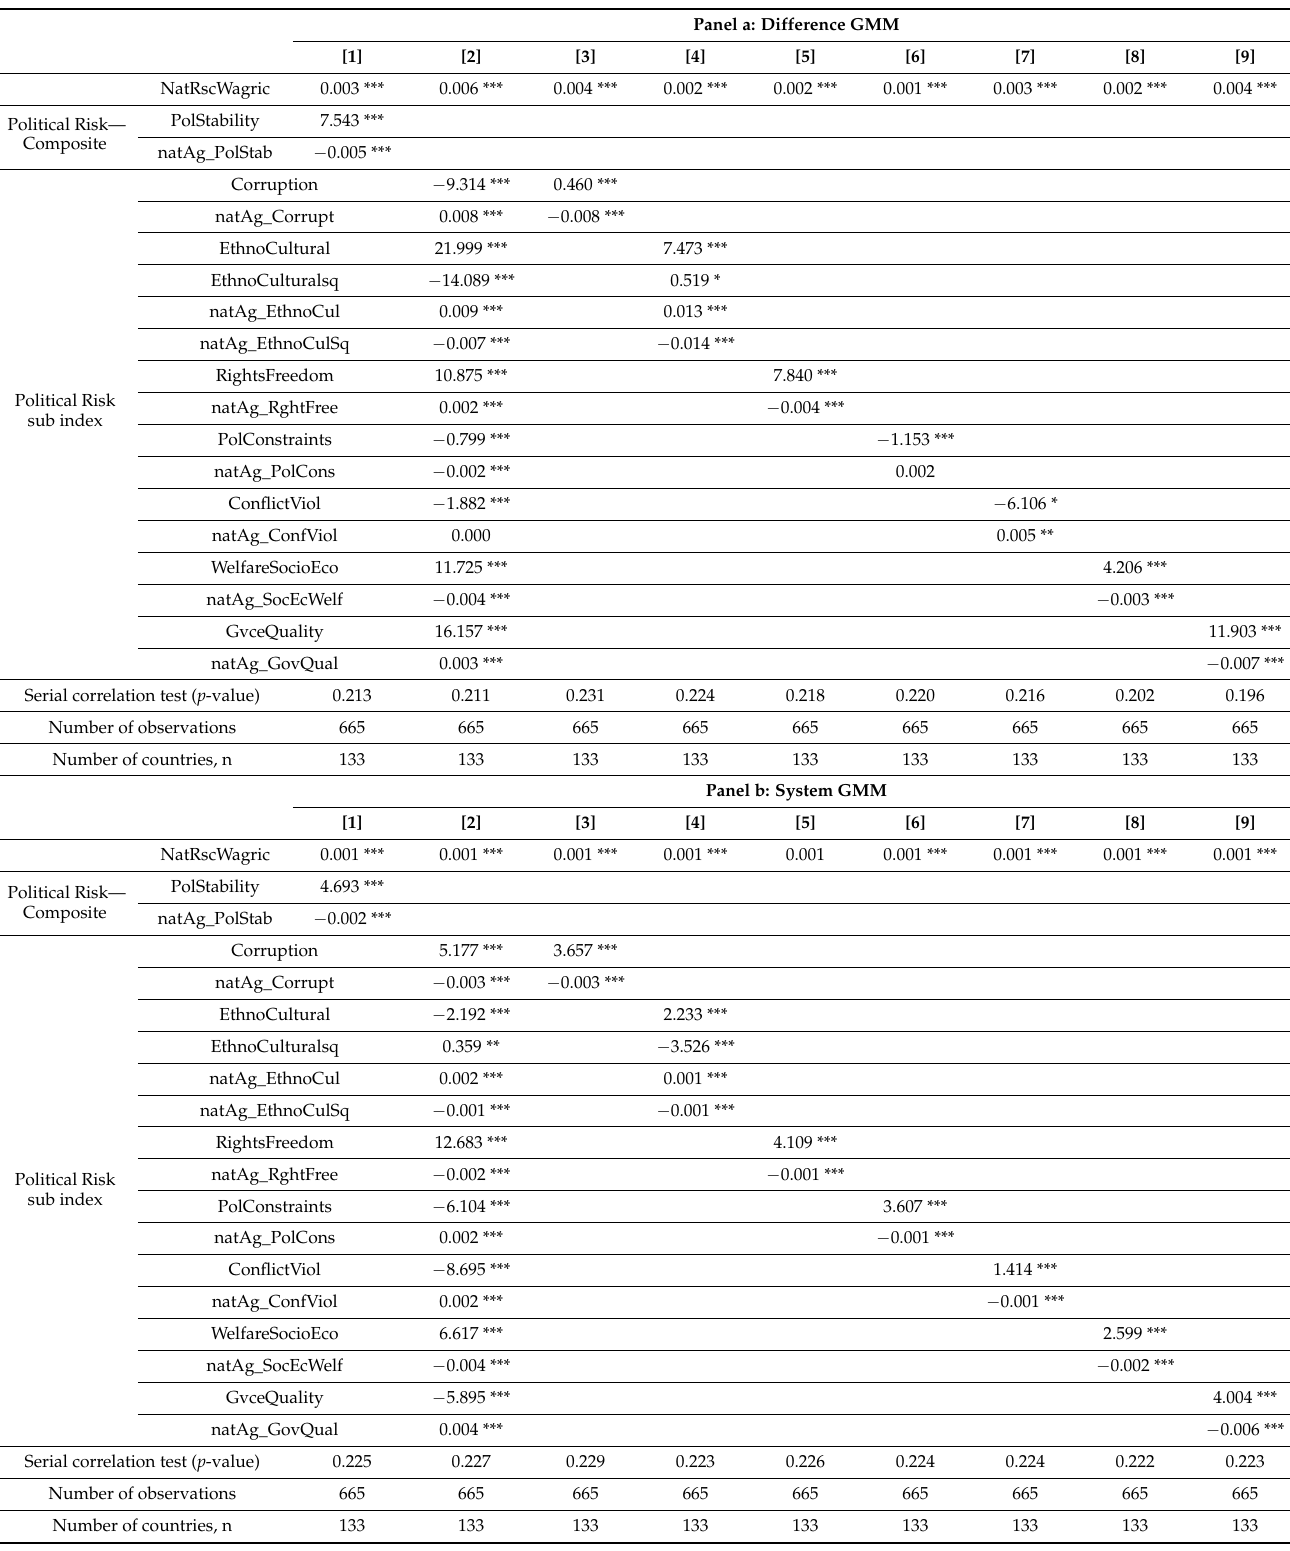
Table 6. Political Risk, Natural Resources, and FDI Revisited—Dynamic Panel Data Models. Panel a: Difference